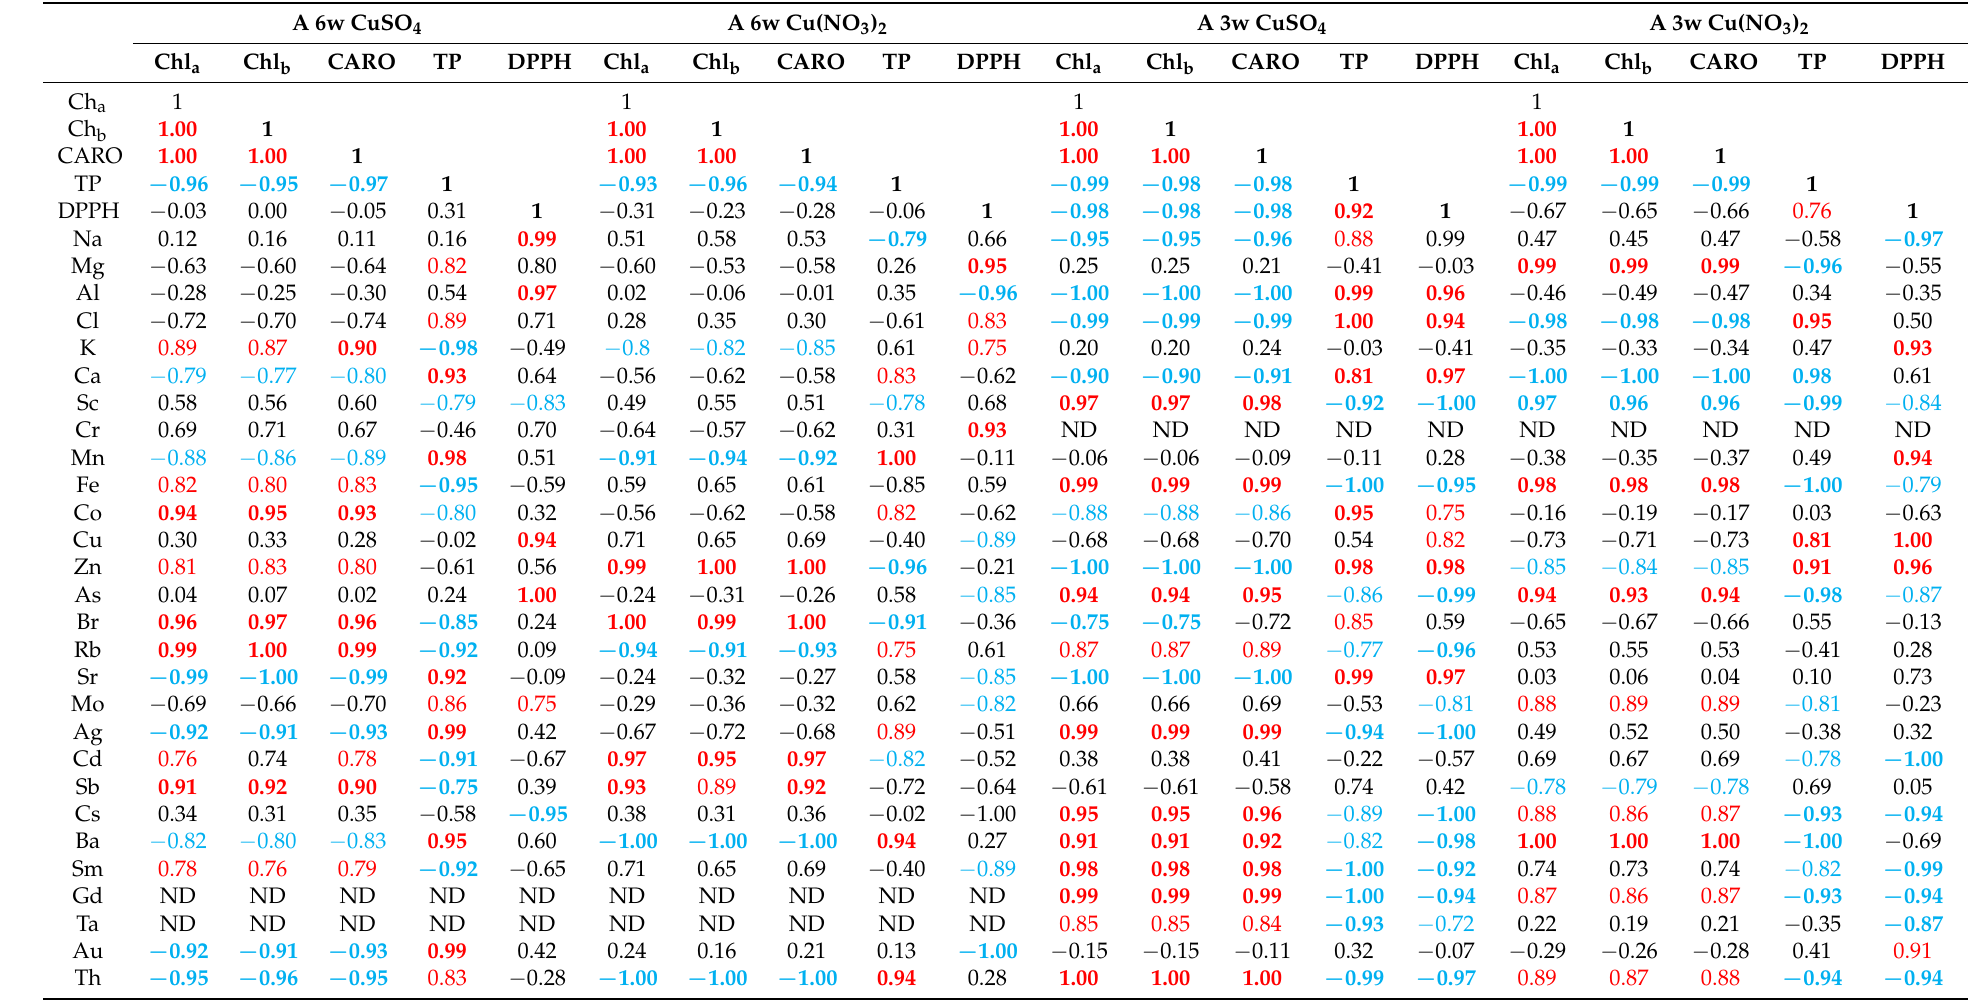
Table 3. Correlation of elemental content with bioactive compounds in aerial part of wheat grown in soil with addition of CuSO 4 and Cu(NO 3 ) 2